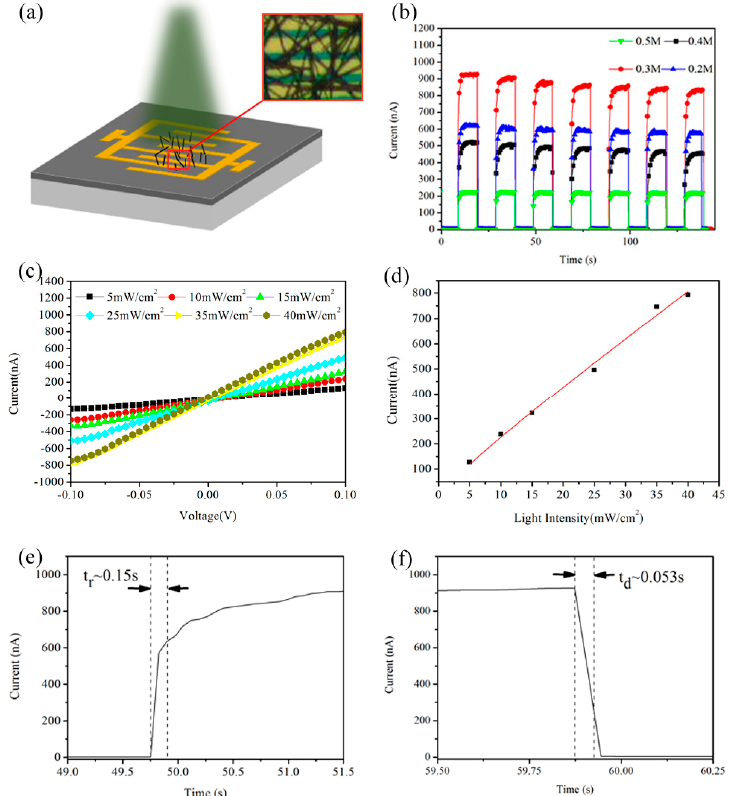
Figure 5. The photoresponsive properties of the photodetector based on MAPbI 3 nanowires. ( a ) The schematic illustration of a photodetector; ( b ) the I-t curves of the perovskite nanowire photodetector measured under 532 nm light illumination (40 mW/cm 2 ) at a low bias voltage of 0.1 V; ( c )